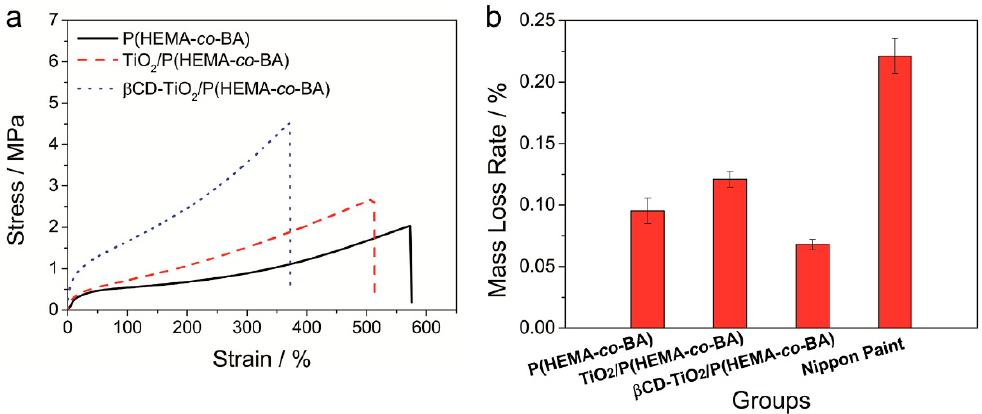
Figure Figure 7. Mechanical properties and wear resistance of coatings: ( a ) Stress–strain curves of P(HEMA- co-BA), TiO 2 /P(HEMA-co-BA) and β -CD-TiO 2 /P(HEMA-co-BA); ( b ) comparison of mass loss rate between self-made coatings and commercial coating (Nippon paint).